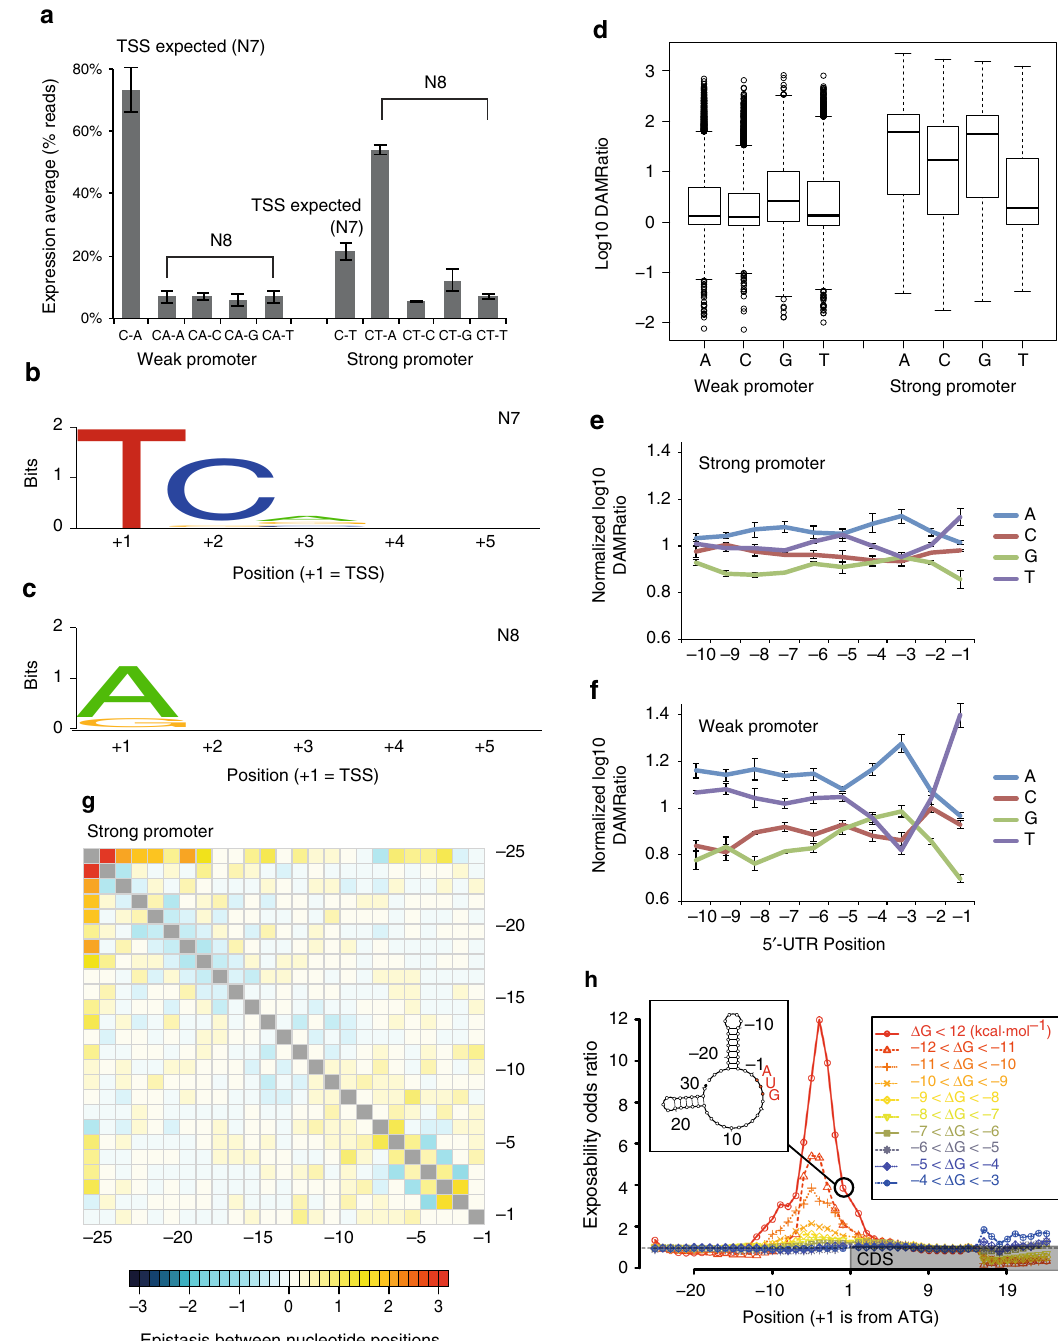
Fig. 4 The effects of alternative transcription start sites and deep-sequence analysis of the 5 ′ -UTR regions of M. pneumoniae . a Expression average according to real TSSs. Error bars represent standard deviation of two biological replicates. b Logo for sequences of N7 mRNAs with the strong promoter ( n = 4637). c Logo for sequences of N8 mRNAs with the strong promoter ( n = 9863) b , c We used N7 and N8 mRNAs commonly found in both RNA-seq experiments. The sequence logos were generated by WebLogo. d DAMRatio distributions according to the fi rst randomized bases (theoretical +2). e The effect of speci fi c nucleotides near the TSC on protein levels in the strong promoter set-up. DAMRatios were normalized within each subgroup starting with the same base. The fi rst four positions upstream of the start codon are the key determinants of protein expression. f The effect of speci fi c nucleotides near the TSC on protein levels in the weak promoter set-up. e , f Error bars represent standard deviation of four subgroups. g Epistatic interactions between nucleotide positions of the 5 ′ -UTR in the case of the strong promoter. The fi rst and second bases have strong epistatic interactions. h Investigation of structural effects near the TSC on protein levels for the strong promoter set-up. A secondary folding structure of mRNA is shown as an example. In this case, we considered that bases − 22 to − 3 and 15 to 29 are hidden (inside the structure) and that the others are exposed (outside the structure). We assessed whether a speci fi c position is exposed or not, and then compared the level of exposure for each site in high-productive and low-productive sequences. To remove the folding energy effect, we binned sequences with Δ G = 1 kcal mol −